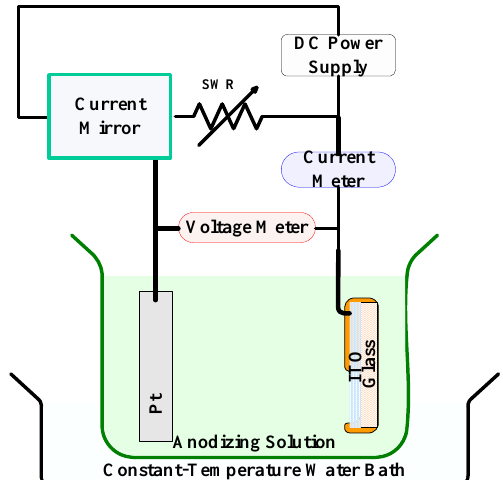
Figure 2. An indium tin oxide anodic oxidation system. The current mirror produced a constant current, and the optimal current condition is 0.6 mA/cm 2 . An electrolyte consisting of tartaric acid, ethyl alcohol, and DI water in the ratio of 3.5 g: 250 cc: 50 cc is